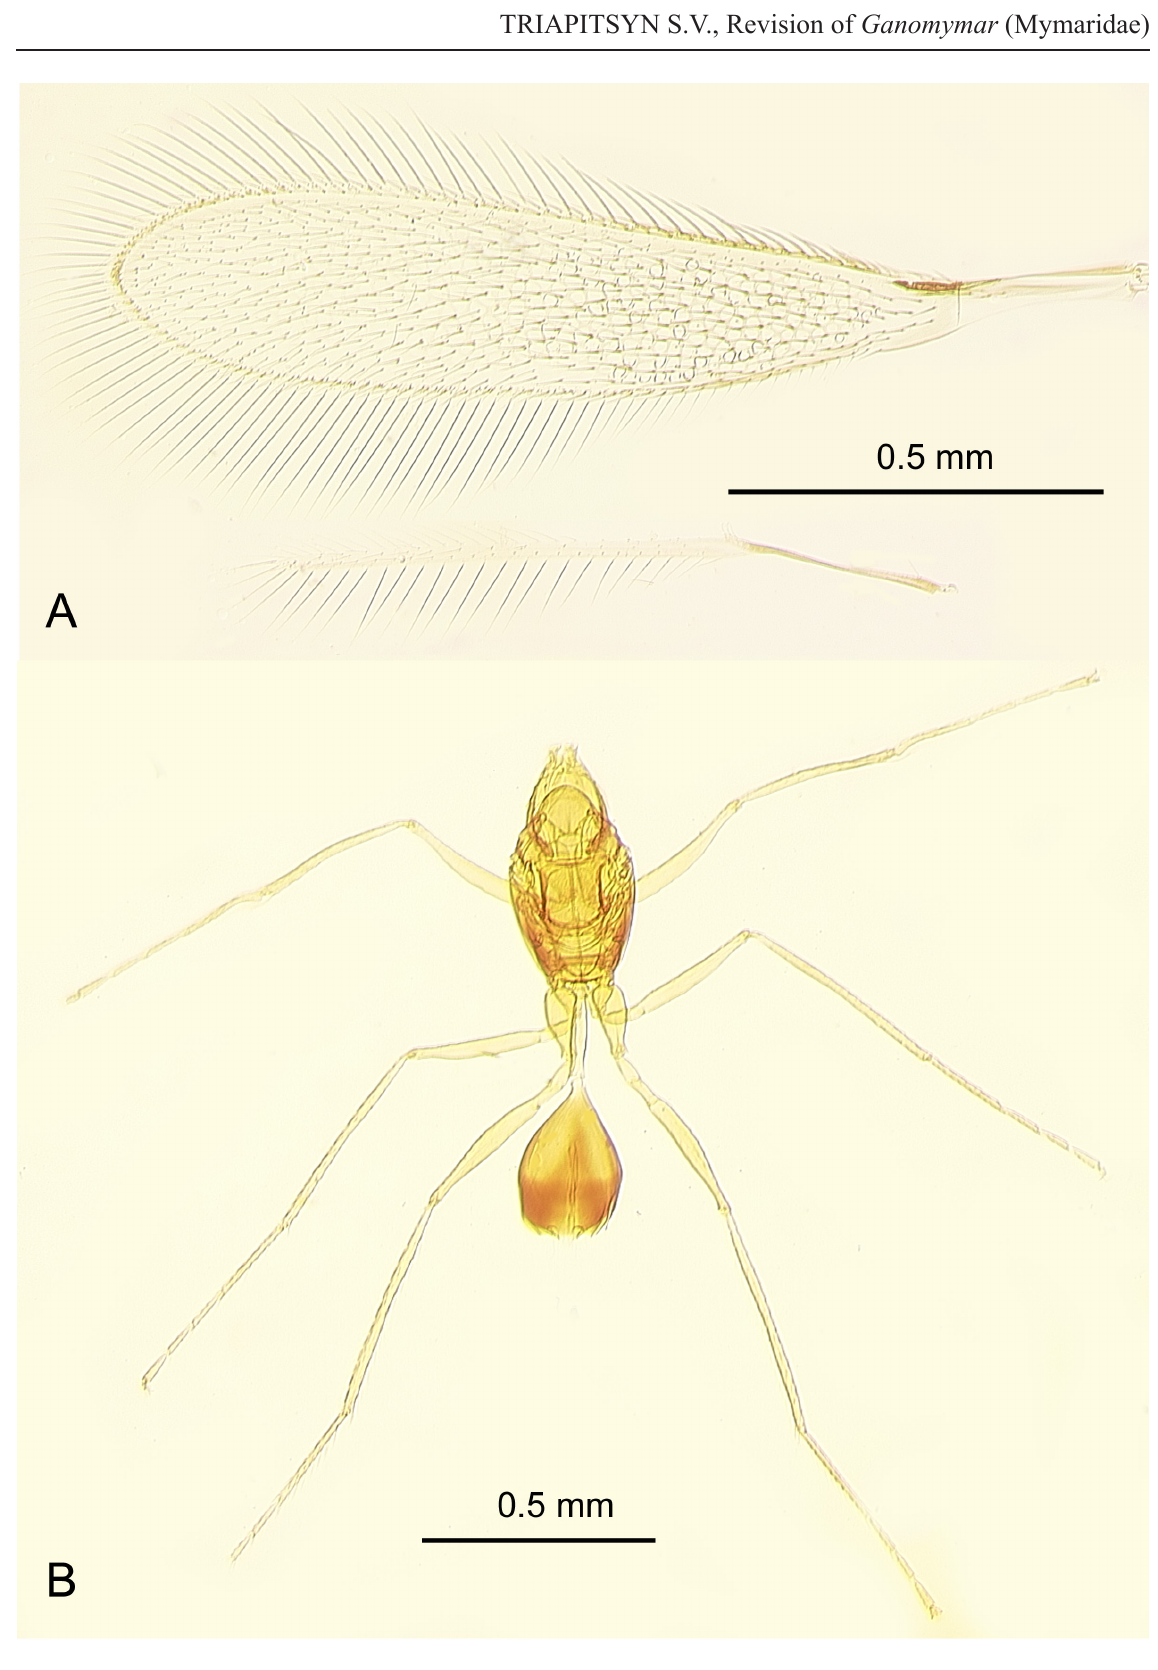
Fig. 3. Ganomymar caslot sp. nov. A . Fore and hind wings, ♀ , holotype (CAS). B . Mesosoma, metasoma and legs, ♂, paratype (CASENT